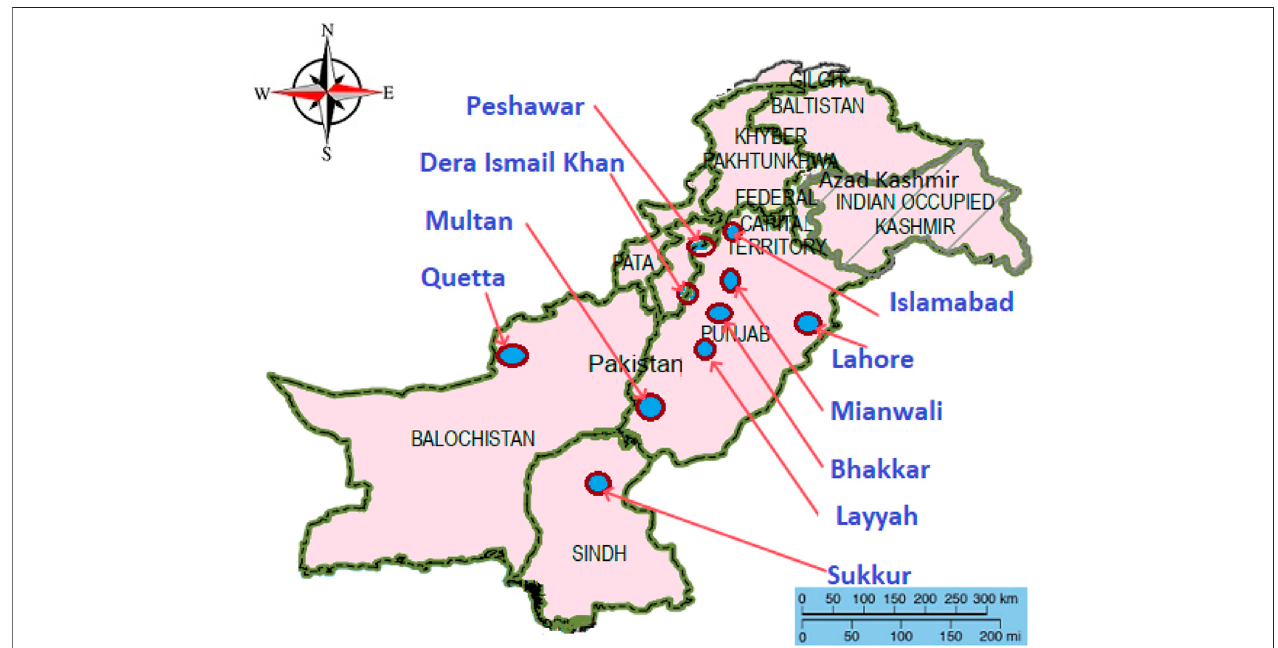
FIGURE 2 | The geographical location of our